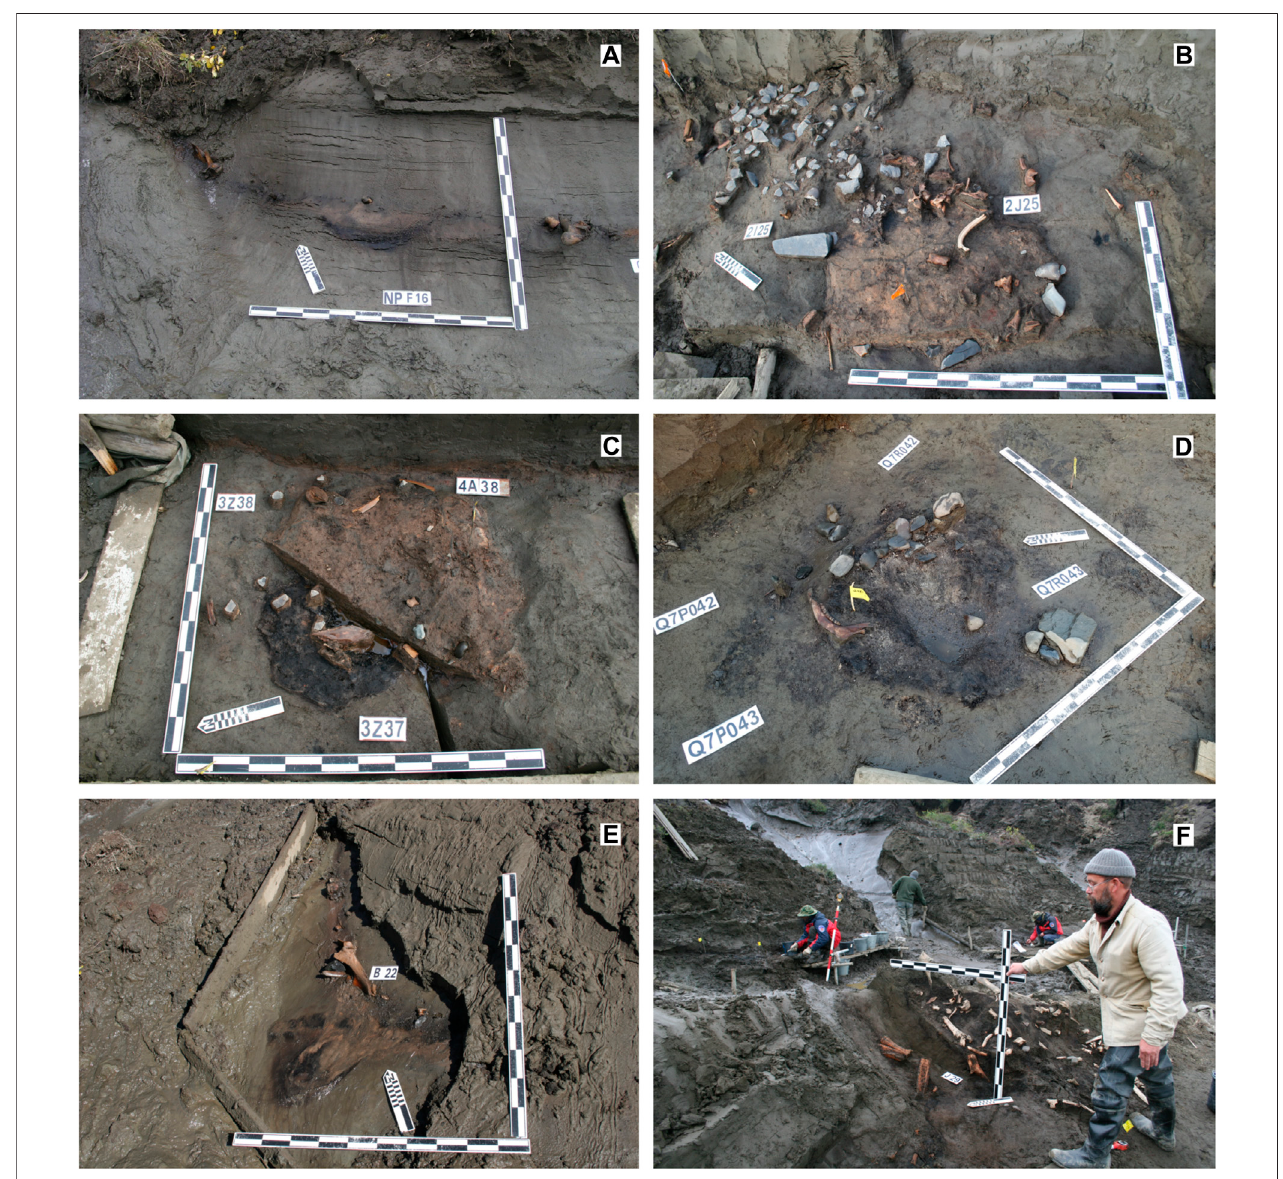
FIGURE 7 | Hearth structures opened in the culture-bearing deposits of the Yana site complex: (A) – 20 cm thick cultural layer in the frozen front within the excavation area, depression related to the hearth structure is clearly seen at the crossing of F16 excavation unit of the Northern Point area, excavations of 2004; (B) – excavated habitation surface with stone knapping workshop area near the hearth discovered in 2J25 excavation unit, excavations of the NP area in 2009; (C) – hearthstructurein3Z37excavationunitatNPareain2008; (D) – hearthstructureinQ7R043unit,excavationsattheYanaBareaoftheYanasitecomplexin2018; (E) – cryogenicdeformationofthehearthstructure observedinthefrozenwallnexttothepolygondepositcontactwiththeiceveinobservedin C 22unit, NorthernPoint, in 2005; (F) – cryogenic deformation observed in the frozen wall next to the contact between the ice vein and the polygon deposit in J29 unit, NP area in